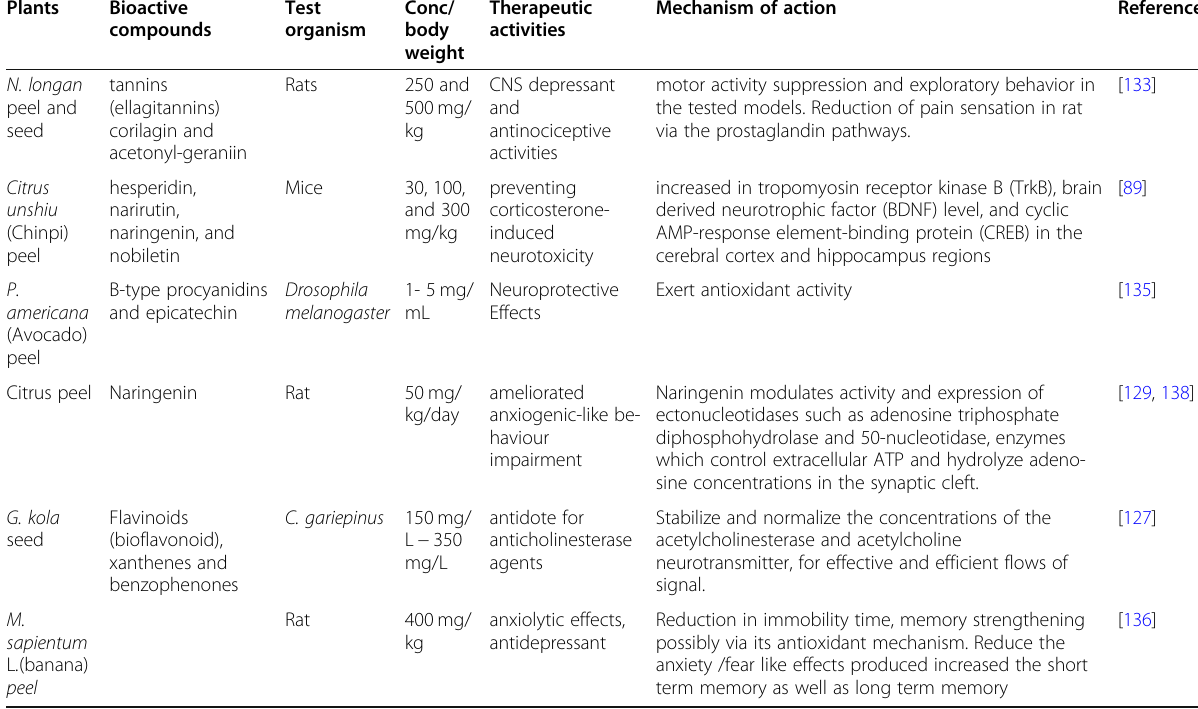
Table 8 Neuroprotective properties of some peels and seed extracts